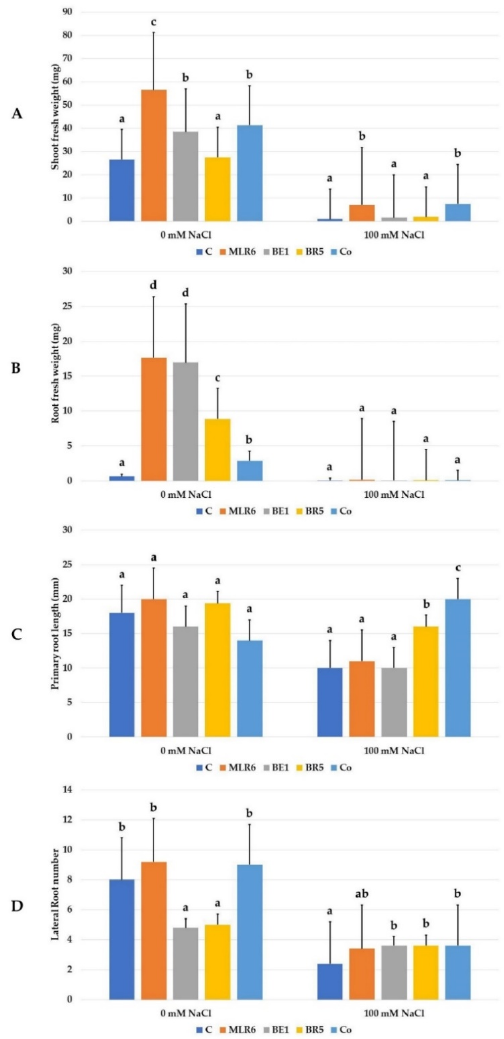
Figure 9. Effect of bacterial isolates on ( A ) shoot fresh weight (mg), ( B ) root fresh weight (mg), ( C ) primary root length (mm), and ( D ) lateral root number of Arabidopsis seedlings exposed to NaCl (0, 100 Mm) concentrations. Data present mean ± standard error. Bars labelled with different letters are significantly different among the treatments at p < 0.05 using Tukey’s HSD test. In each bar groups, bars labelled with the same letter are not significantly different from each other according to Tukey’s HSD at p <